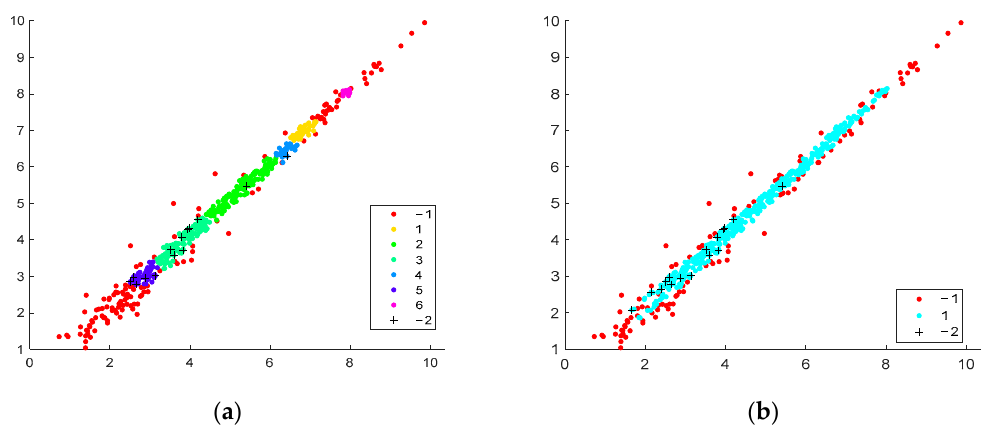
Figure 6. Clustering of the 8th batch, the batch of 511 genes; Tstd = 0.3. ( a ) Euclidean distance, 15 std genes. ( b ) Mahalonobis, 0.2, 5, 17 std genes.